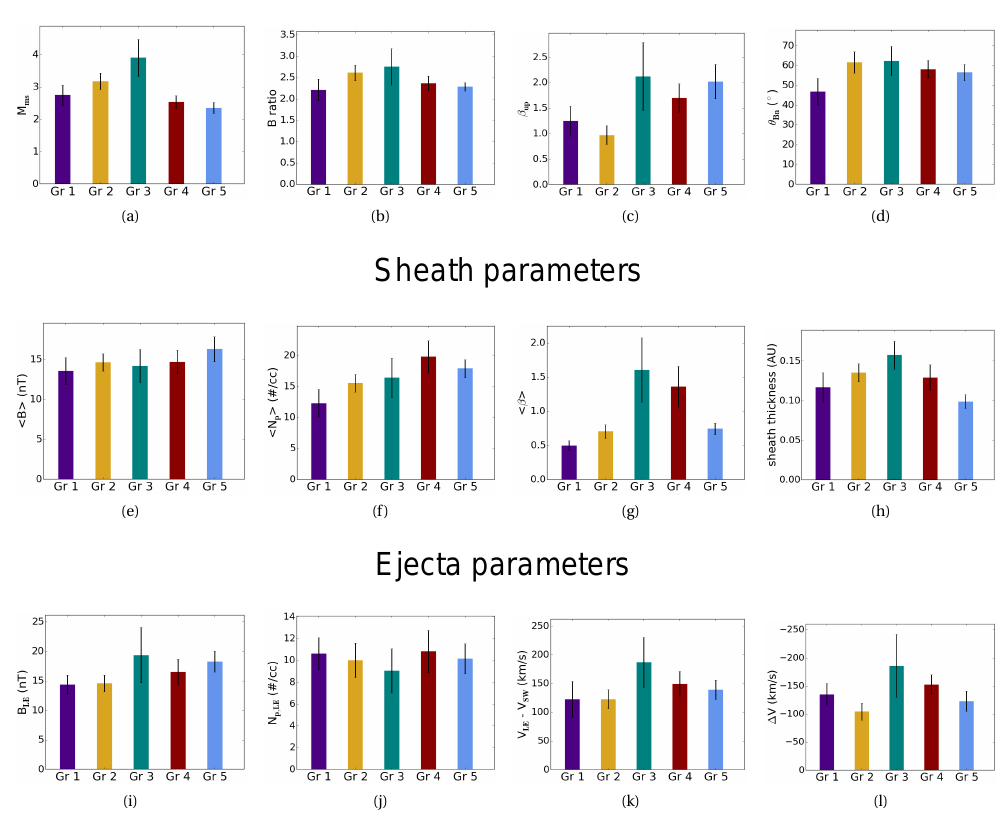
Figure 4. The investigated parameters and their relation to PMS groups. Histograms show the averages, and the error bars show the extent of one standard deviation. First row – shock parameters: (a) magnetosonic Mach number, (b) downstream-to-upstream magnetic field magnitude ratio, (c) upstream plasma beta, (d) shock normal. Second row – sheath parameters: (e) average magnetic field magnitude, (f) average proton number density, (g) average plasma beta, (h) sheath thickness. Third row – CME ejecta parameters: (i) leading edge magnetic field magnitude, (j) leading edge proton number density, (k) difference between leading edge and upstream speed, (l) velocity gradient (only for expanding CME